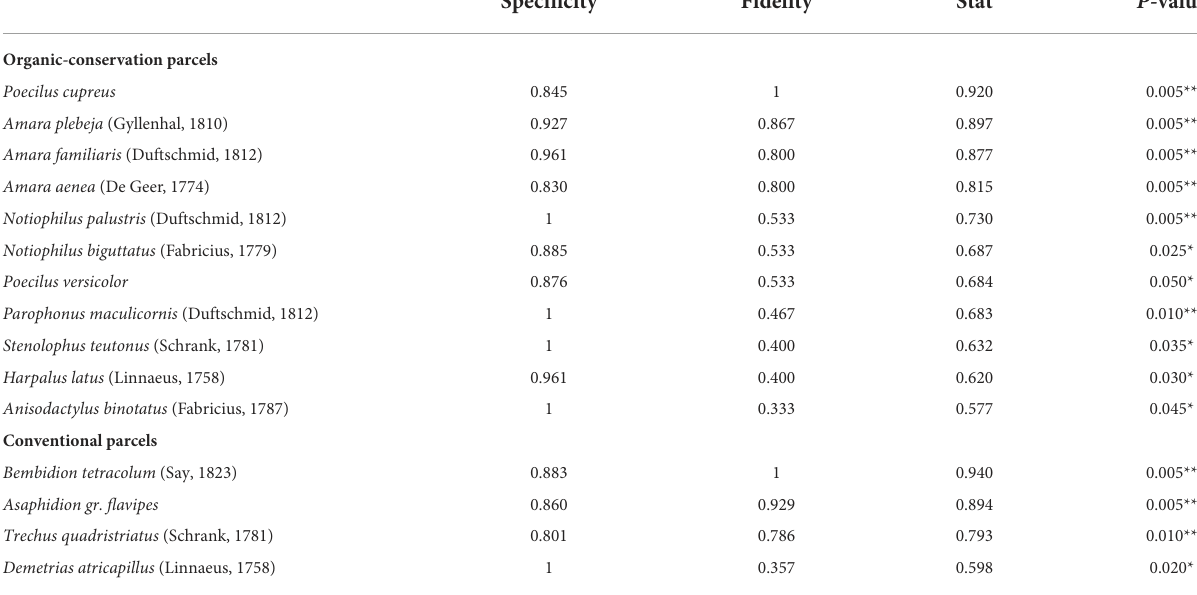
TABLE 2 Specificity and fidelity components of value index (indval) for carabids in organic conservation parcels and conventional ones, last column indicates the significance of the relationship between the species and the targeted system type.